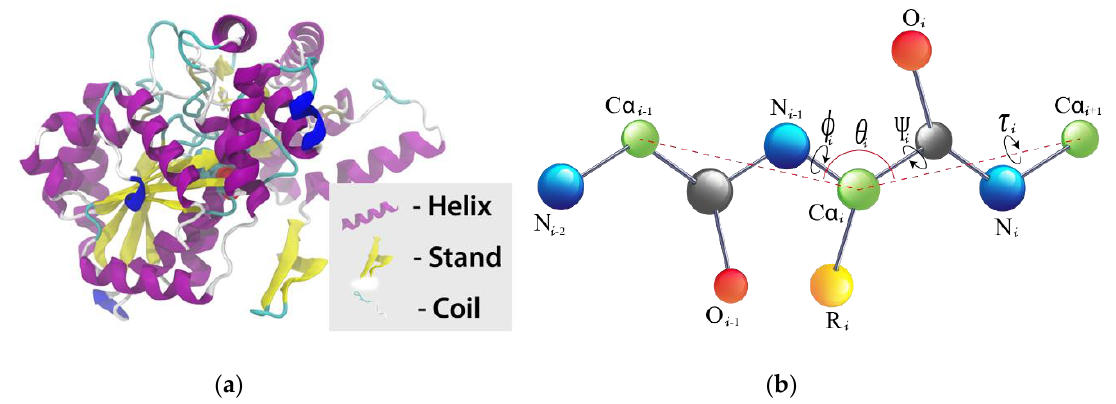
Figure 1. Illustrations of the secondary structure of a protein and local backbone torsion angles in amino acids ( a ) the helix, strand and coil for a protein (picture source: freepik.com) while ( b ) illustrates torsion angles associated with the protein backbone. Dihedral angle for the different bonds are discussed above.